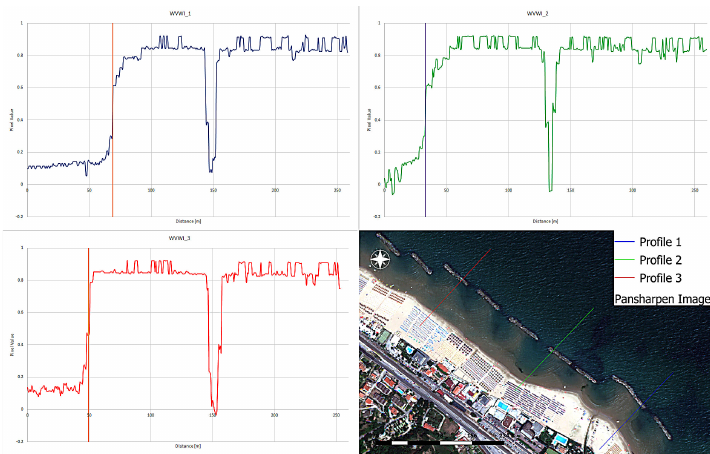
Figure 1. Spatial profiles of WVWI (WorldView Water Index): along the x-axis the distances (m) and along the y-axis the WVWI pixel values; the vertical line represents the inflection point in which the threshold between water and sand has been set.